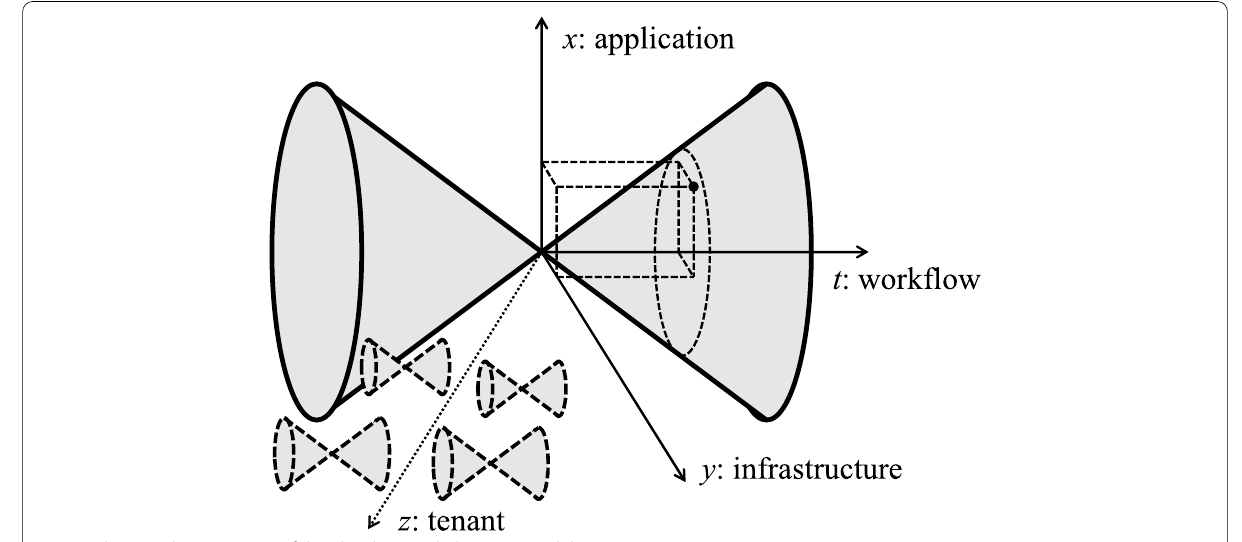
Fig. 1 The coordinate system of the cloud-native light-cone